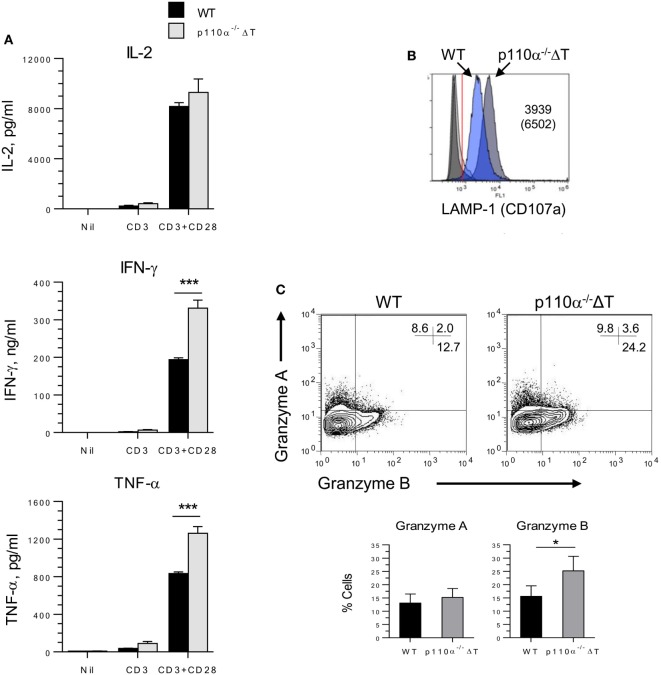
PI3-kinase p110α deficiency enhances activation and effector functions of CD8+ naive T cells. (A) Naive (CD8+ CD62L+) CD8+ T lymphocytes were isolated from the spleen of WT or p110α−/−ΔT mice. They were activated for 3 days with anti-CD3 and anti-CD28, as shown in the figure. Then, the culture supernatants were taken and analyzed for IL-2, IFN-γ, and TNF-α content. Data from three experiments ± SE. Significant differences (***p < 0.001) between groups are indicated, as determined by the Student’s t-test, n.s., not significant. Alternatively, CD8+ T cells were activated 72 h with anti-CD3 plus anti-CD28 antibodies, washed, and cultured 72 h in the presence of IL-2. Then, the expression in the expanded cells of LAMP-1 (B), or Granzymes A and B (C) was analyzed by flow cytometry. Mean ± SE from three independent experiments (Granzyme A, B). Significant differences (*p < 0.05; ***p < 0.001) between means are indicated, as determined by the Student’s t-test.